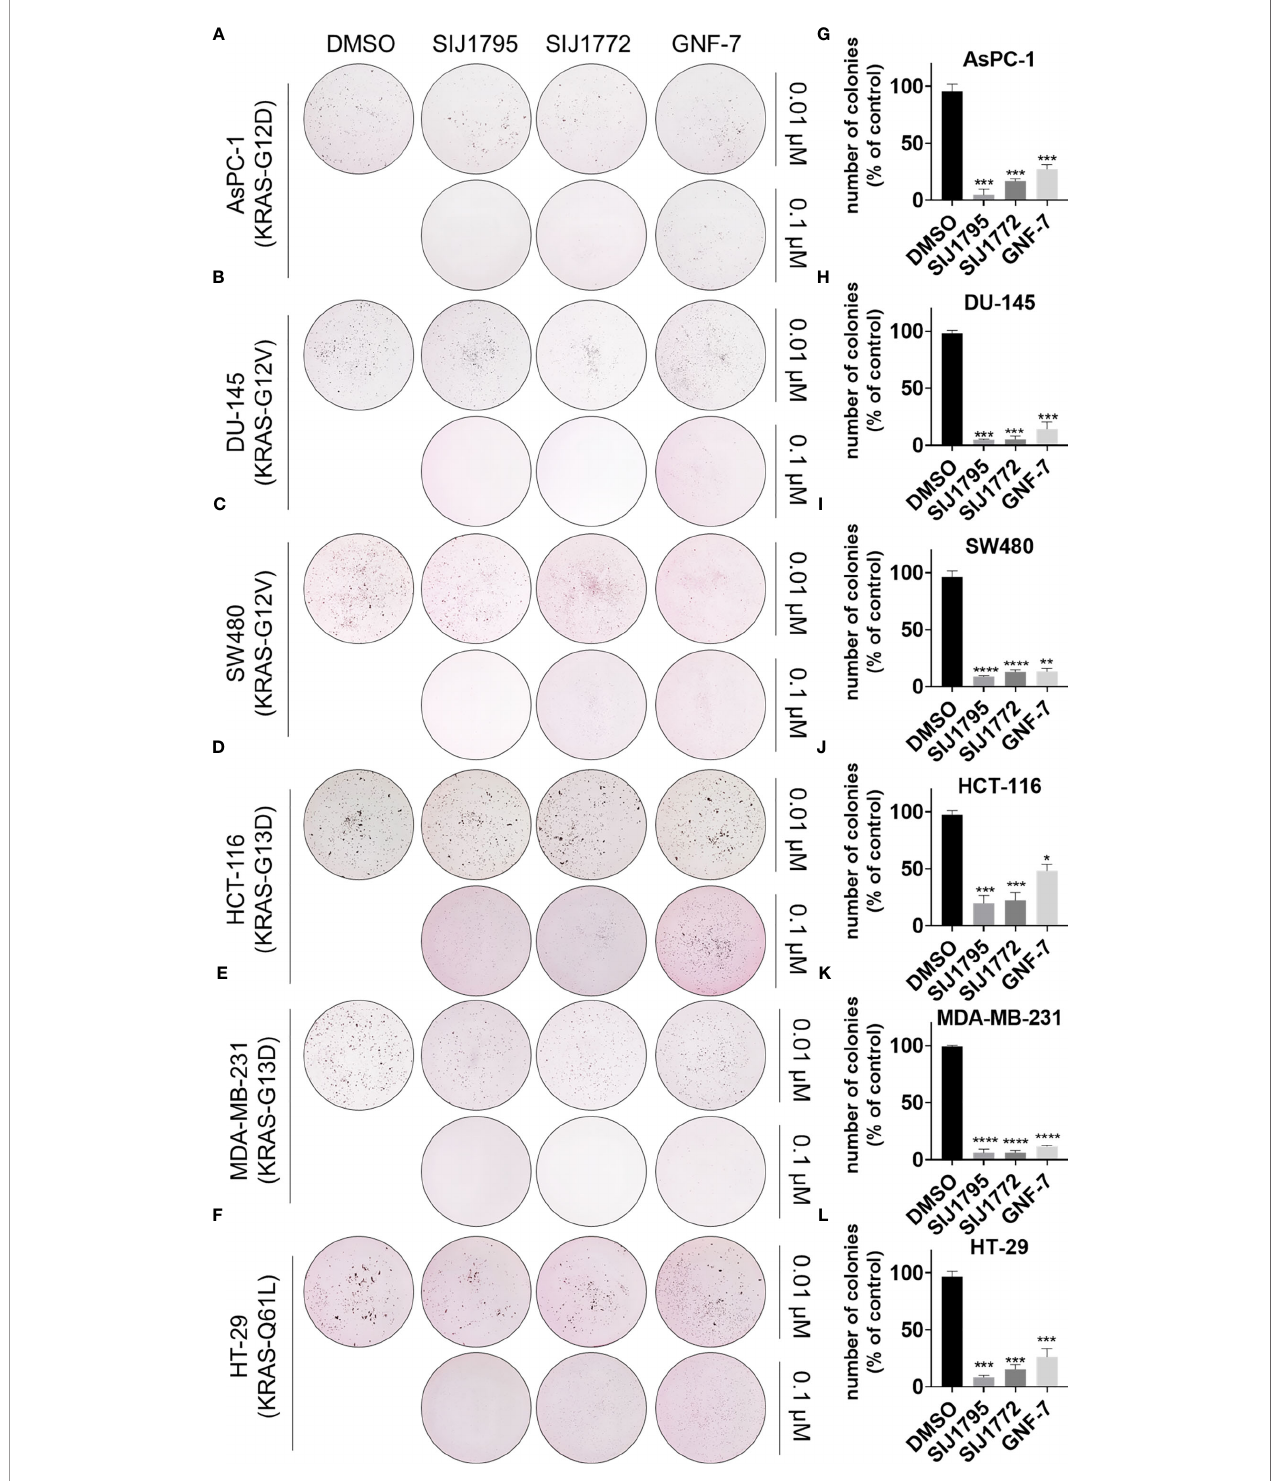
FIGURE 8 | (A – F) Soft agar assay results for evaluating the effect of SIJ1795 and SIJ1772 on anchorage independent growth abilities on cancer cells harboring mtRAS. Cells were incubated with indicated compounds (0.01 µM or 0.1 µM) for 14 days. After staining with crystal violet, colonies were photographed without magni fi cation. (G – L) Number of colonies (% of control) upon treatment with indicated compounds at 0.1 µM concentration were determined by ImageJ (n = 3, respectively). Statistical signi fi cance was calculated by a one-way ANOVA analysis (*p < 0.05, **p < 0.01, ***p < 0.001, ****p <